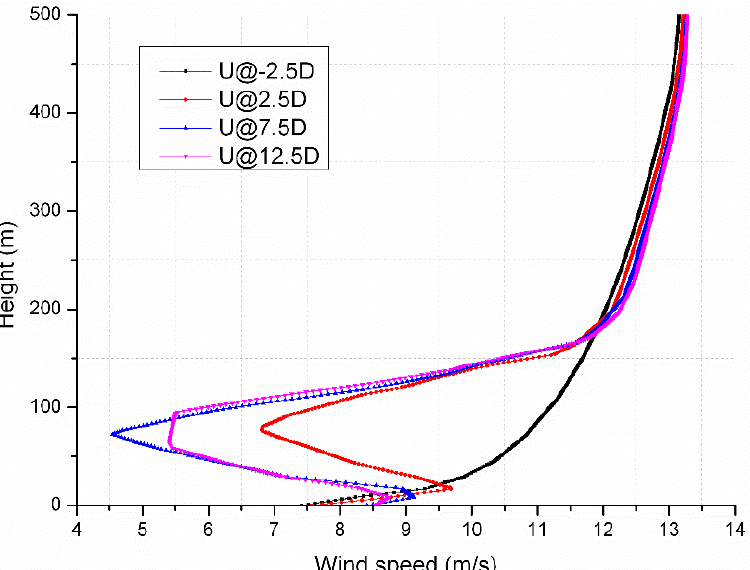
Figure 8. Axial direction wind speed profiles along vertical direction at various axial positions in the center plane for the case 3 (L2 =